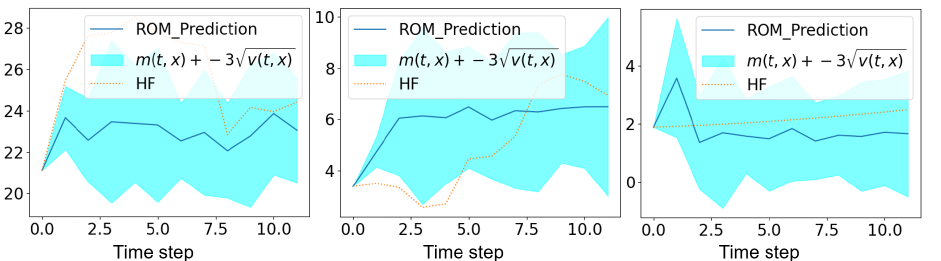
Figure 24. High-fidelity Yales2 horizontal velocity projected on the Cartesian mesh in brown and the horizontal component of the mean prediction of the Bayesian ROM in dark blue, at three spatial points during 0.005 s starting from 0 s. The clear blue zones are the ones that are contained in three standard deviations around the mean prediction of the ROM denoted m ( t , x ) . The mean prediction is obtained using an aggregation of 10 samples of the Navier–Stokes solution by the Bayesian nonlinear